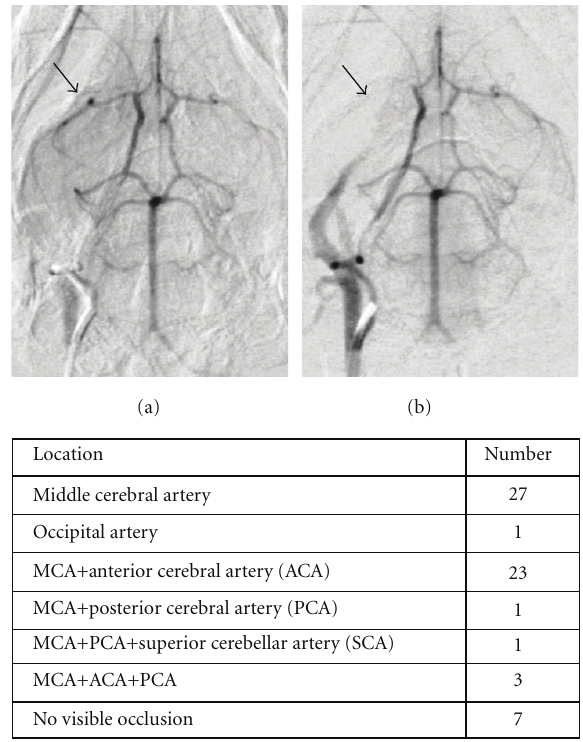
Figure 1: Angiography results. Pre-embolization angiogram (a) demonstrates filling of the MCA. Occlusion and absence of filling are evident in postembolization angiogram (b). Arrows indicate location of the MCA. Location of occlusion and numbers of animals a ff ected by each type are given in the